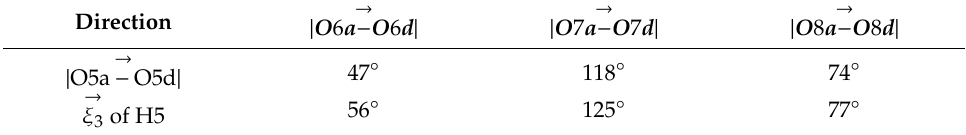
Figure 3. The molecular cluster of citric acid. In the central molecule, an orientation of the eigenvectors of the 1 H chemical shielding tensors is shown (the eigenvectors associated with the smallest, mid, and highest eigenvalues are colored in magenta, cyan, and green, respectively). Table 5. Angles between vectors in citric acid that are discussed in the